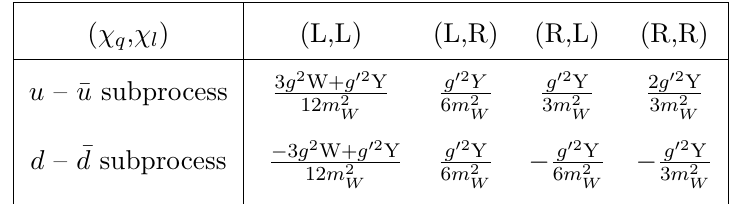
defined in eq. (B.2) for the q χq ,l χl